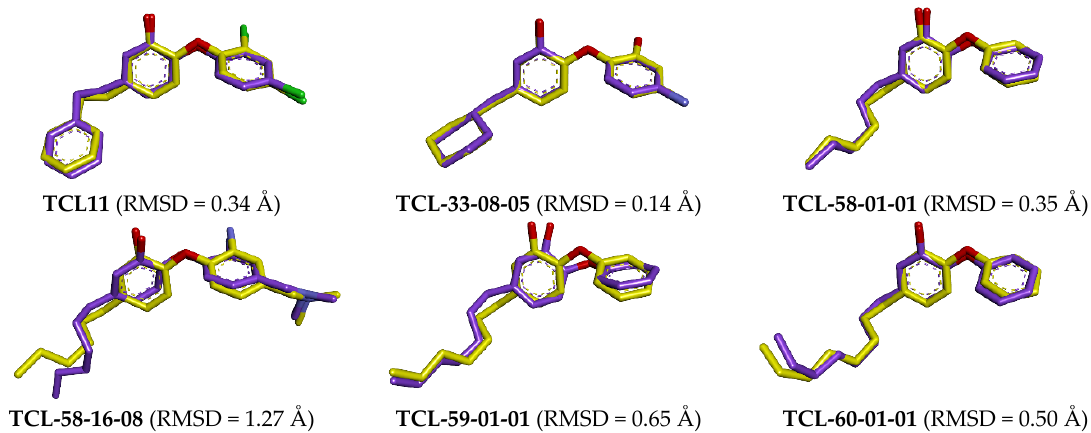
Figure 13. Superimposition of the ligand active conformation from complexes refined by molecular mechanics (yellow carbons, red oxygens, blue nitrogens) and averaged active conformations resulting from MD simulations (purple carbon atoms).